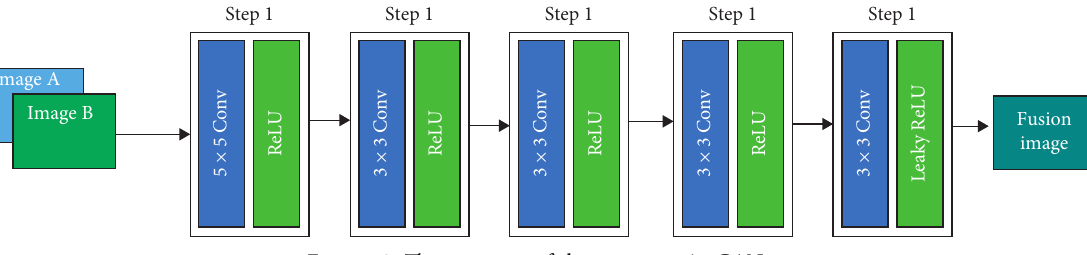
Figure 3: The structure of the generator in GAN.